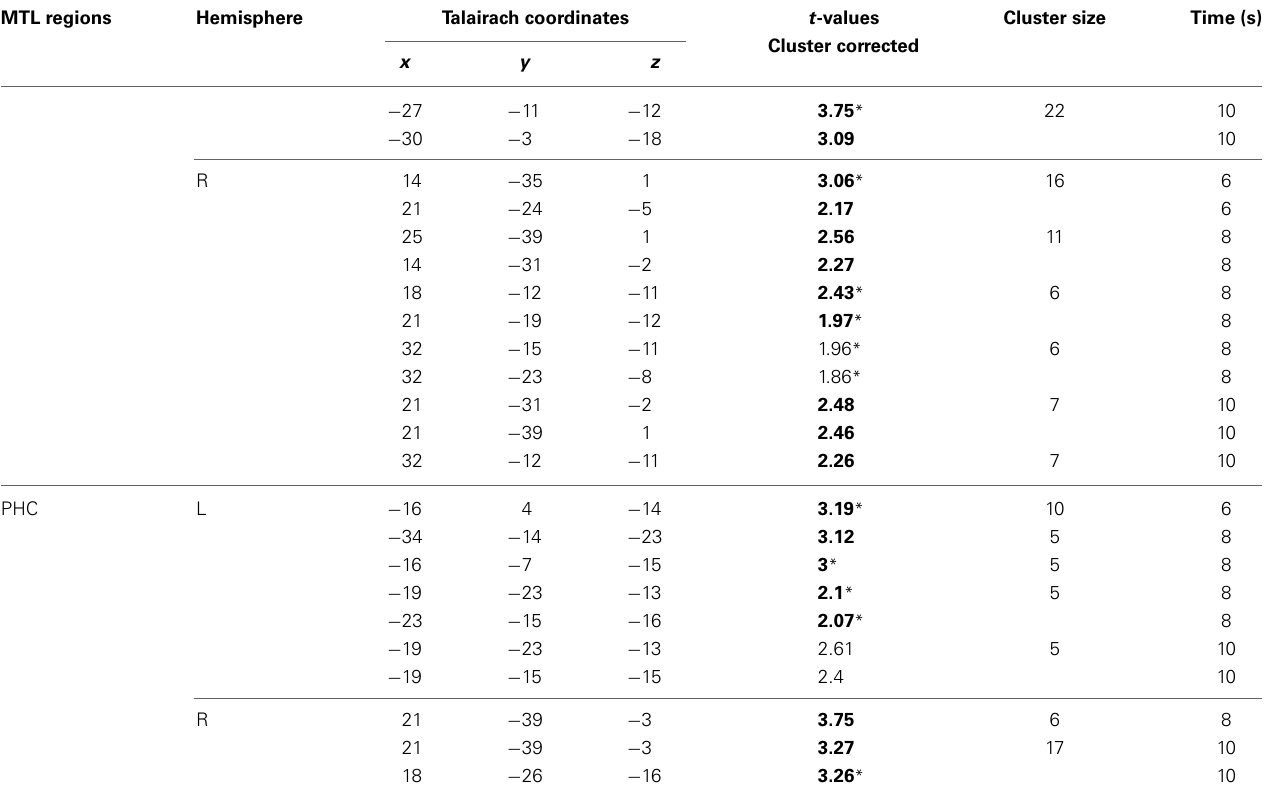
The tableidentifies MTL regions where emotional and neutral RS aresignificant. The displayed t-values correspond tothepeak voxel for eachtime pointafter stimulus onset (where the HDR response was maximal), and represents a significant difference in MR signal between remembered and forgotten items. Emotional RS = (Emotional Hits-Misses) and Neutral RS = (Neutral Hits-Misses). *regions surviving exclusive masking by incidental encoding. ¶ region surviving FDR-anatomical ROI correction. MTL, medial temporal lobe; AMY, amygdala; HC, hippocampus; PHC, parahippocampus; L, left; R, right; RS, retrieval success; HDR, hemodynamic response; MR, magnetic resonance; Cluster Cor., False Discovery Rate-cluster correction. Cluster corrected values are indicated in bold.